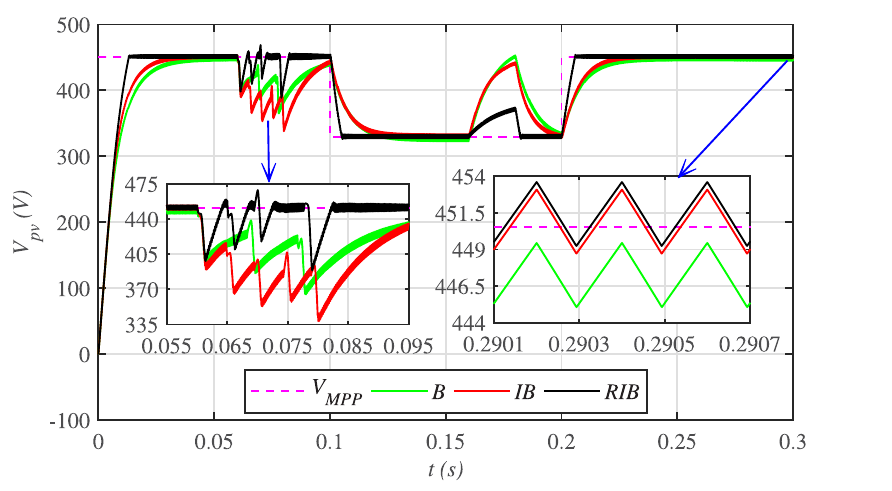
Fig 16. PV array comparative voltages under case 2.